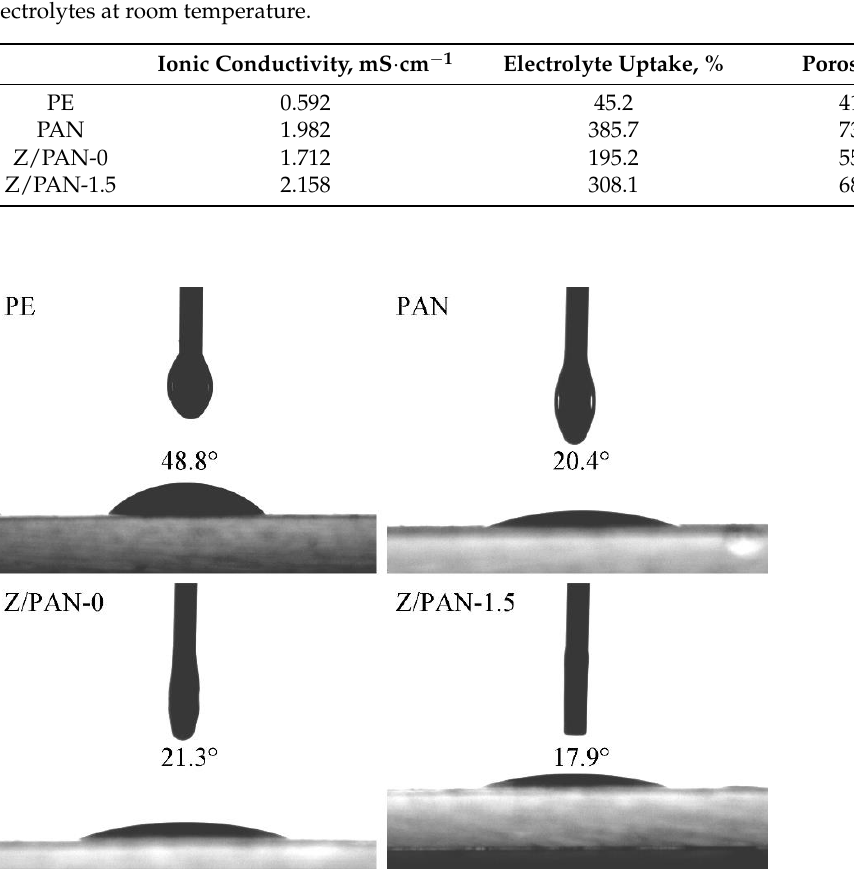
Figure 5. Digital photographs of contact angle of an electrolyte on PE separator, PAN separator, Z/PAN-0 separator, and Z/PAN-1.5 separator.